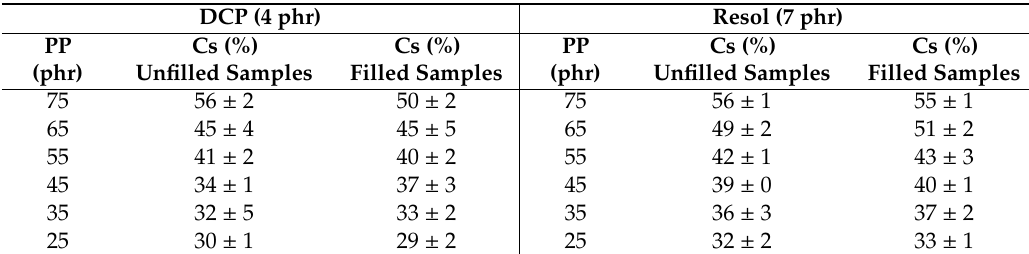
Table 2. Values of compression set for TPV based on a decreasing concentration of the PP phase. Amount of crosslinker in the formulations: 4 phr (DCP) and 7 phr (Resol). Amount of CB: 12 wt %.